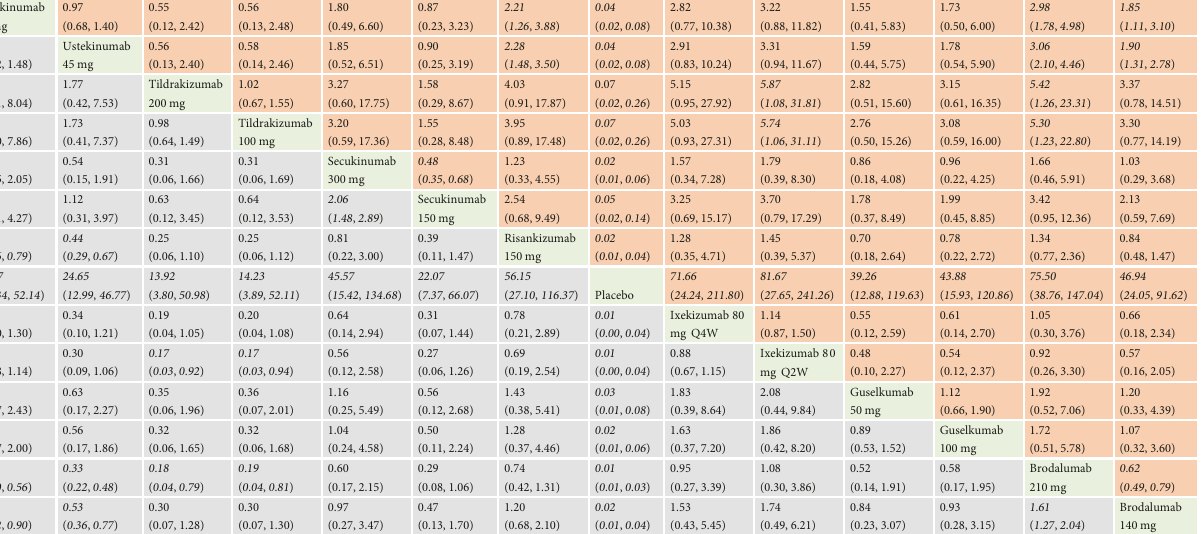
Figure 5: Relative risk with 95% CIs of all interventions from network meta-analysis for PASI 100. Di ff erent interventions in the middle block divide the graph into upper and lower triangles; for the lower triangle, the e ffi cacy estimate is the ratio of the column de fi ning treatment to the row de fi ning treatment. In case that the con fi dence interval does not include 1, if RR > 1 , it favors the column de fi ning treatment. In contrast, if RR < 1 , it favors the row de fi ning treatment. The upper triangle is symmetrical to the lower triangle. The e ffi cacy estimate is the ratio of the row de fi ning treatment to the column de fi ning treatment. The results are mutually reciprocal. Statistically signi fi cant results have been applied with italic